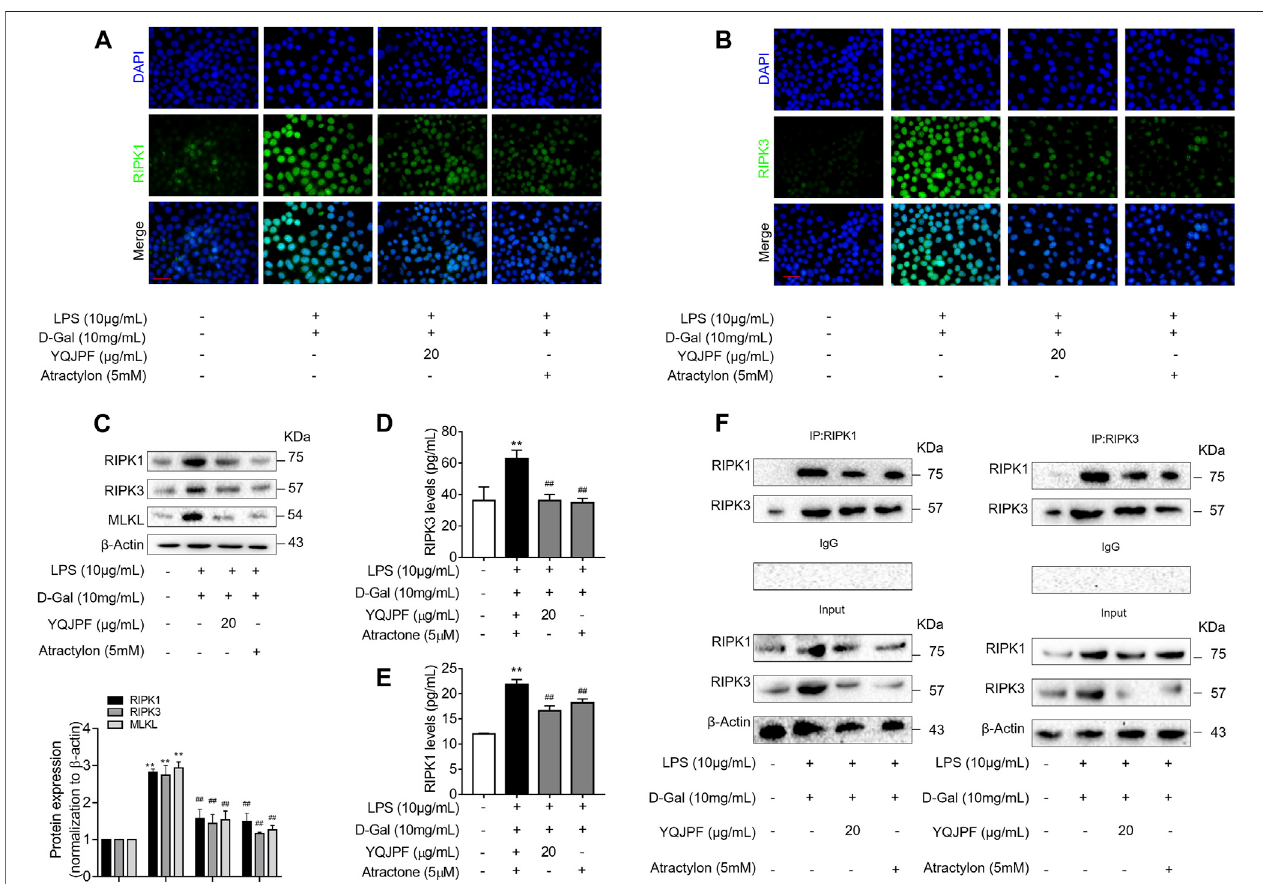
FIGURE7| TheRIPK1/RIPK3-complexisrequiredforYQJPFtoinhibithepatocytenecroptosis invitro .HumanLO2cellsweretreatedwithLPS+D-Galfor4 hand further with YQJPF and atractylone. (A,B) Immuno fl uorescence staining of RIPK1 and RIPK3 in LO2 cells. Scale bar, 50 μ m. (C) Western blot analysis and quantitative assessment of RIPK1, MLKL and RIPK3. (D,E) Expression levels of RIPK1 and RIPK3 in LO2 were detected by ELISA. (F) RIPK1 was immunoprecipitated with its antibody and resulted in co-immunoprecipitation of RIPK3. Immunoprecipitation of RIPK3 with its antibody caused co-immunoprecipitation of RIPK1 in LO2 cells. Data are expressed as mean ± SD ( n (cid:2) 3). *vs. control group, # vs. LPS + D-Gal group; * p < 0.05, ** p < 0.01; # p < 0.05, ## p <